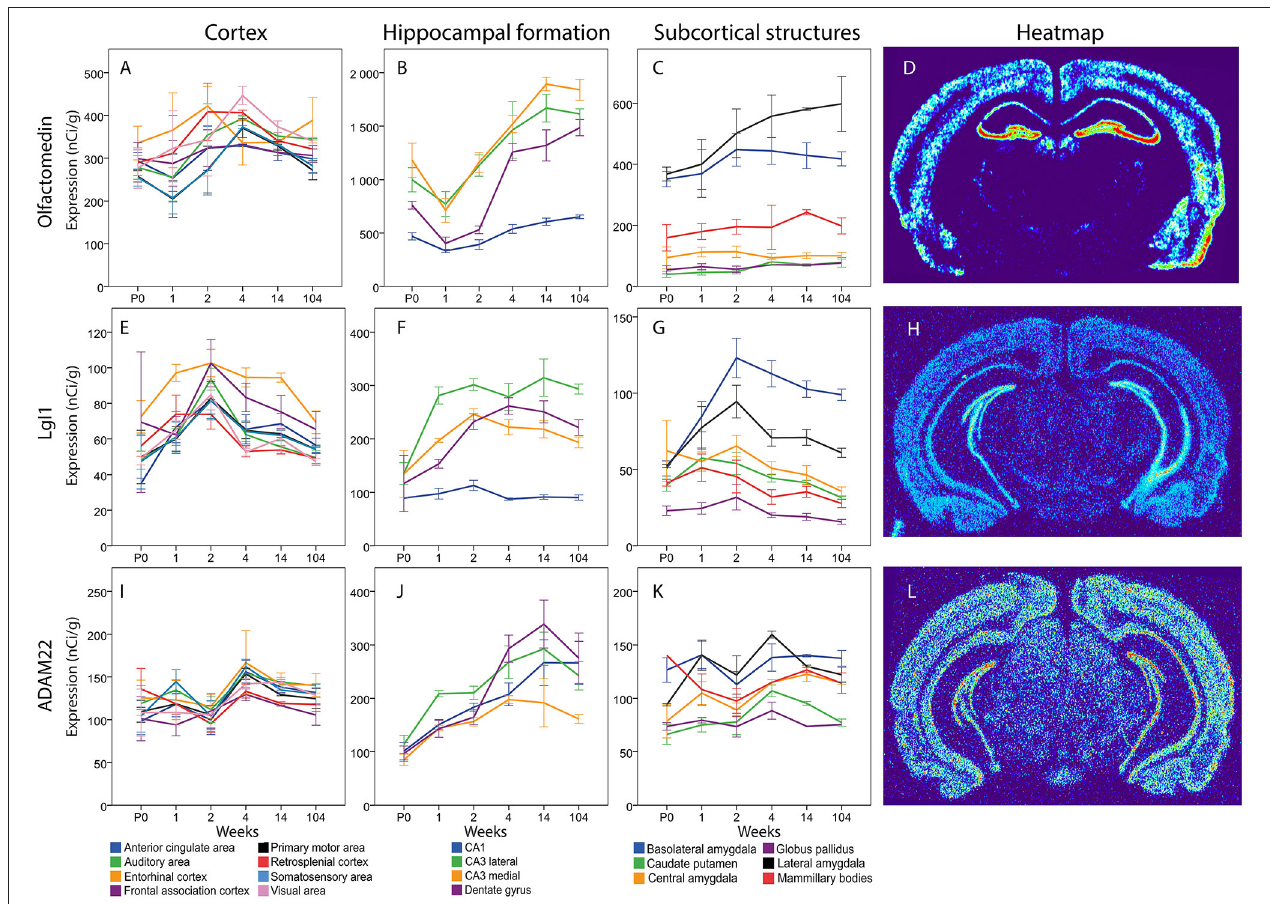
FIGURE 13 | Graphs showing the mRNA expression for Olfactomedin (A–C), LgI1 (E–G) and ADAM22 (I–K) in 18 cerebral regions over time. For full legend see Figure 9 . Heatmaps of the three genes (D,H,L) visualizing expression in 14 week old mice.